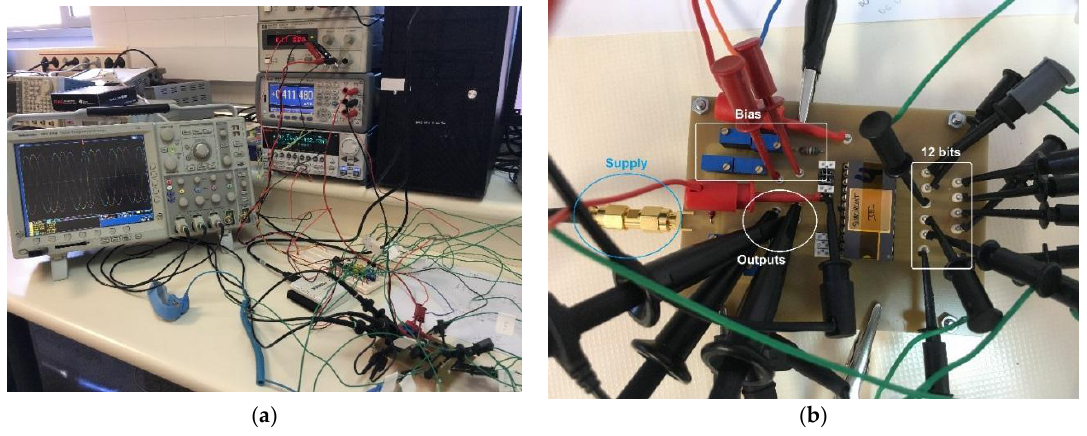
Figure 8. Experimental setup: ( a ) General view of the instrumentation used; and ( b ) A detail of the ASIC connected to the circuit board, indicating the supply and bias lines, the output signals, and the 12 bit digital input.